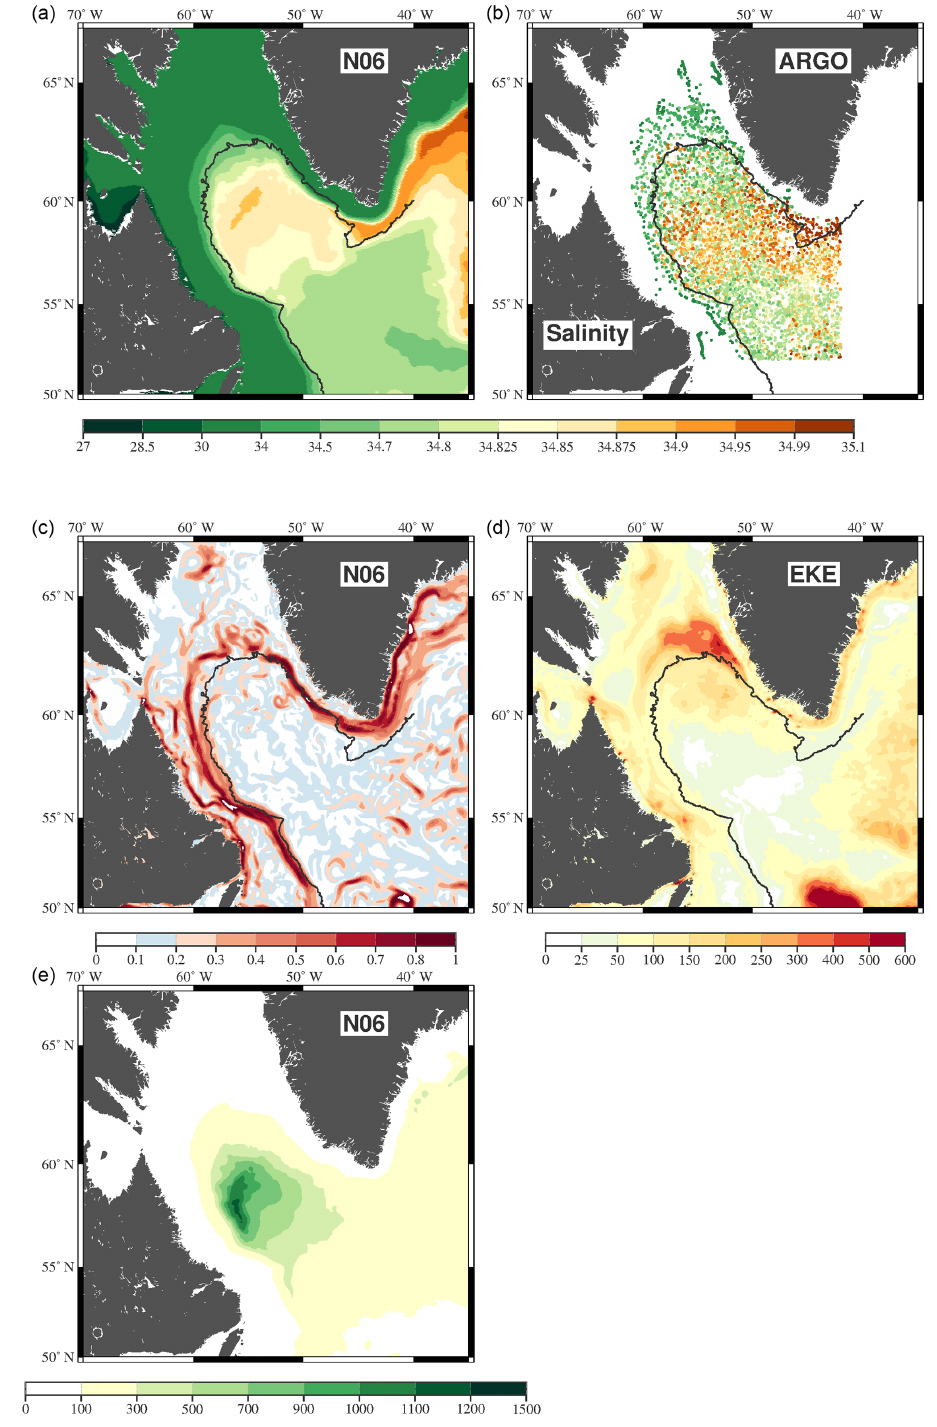
Figure 1. (a) Mean salinity in the top 100m from NEMO-N06. (b) The same as (a) but from Argo data. (c) Speed (ms − 1 ) and (d) mean EKE (cm 2 s − 2 ) derived from the NEMO-N06 model of the top 100m. (e) Mean wintertime (December–March) mixed layer depths (m) from NEMO-N06. All means are calculated for the period of